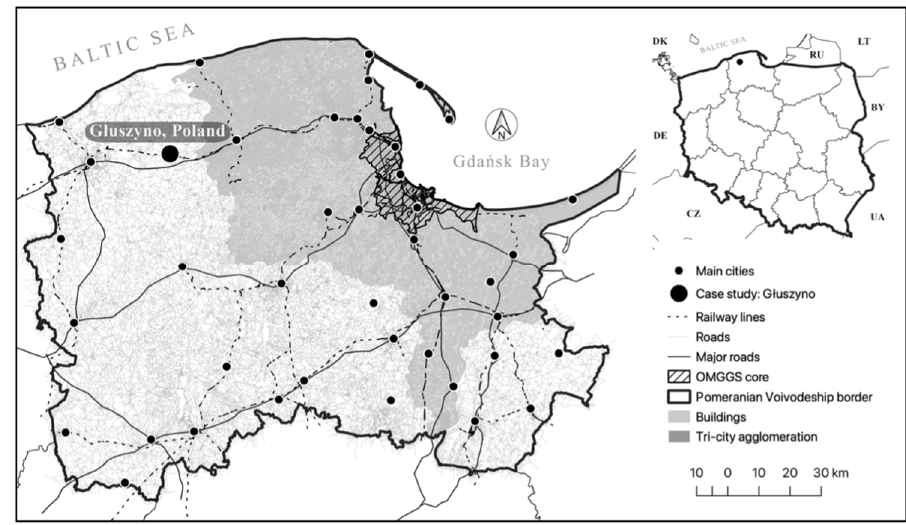
Figure 10. General accessibility to Głuszyno compared to the northern region of Poland—Pomeranian Voivodeship (own study, based on [19,26,76]).